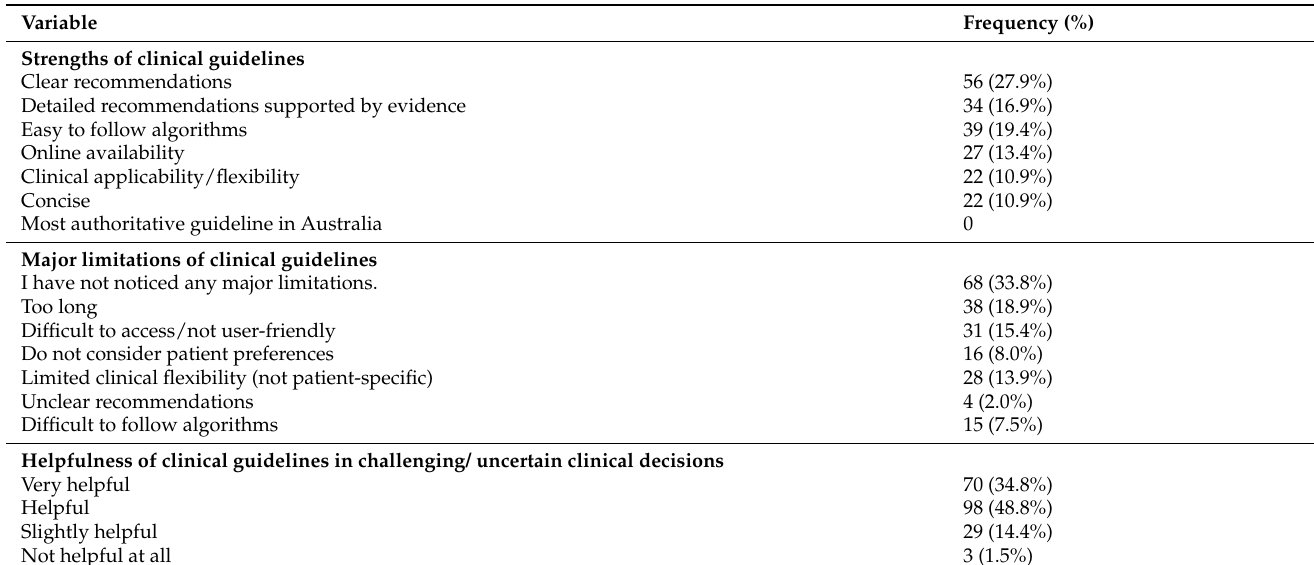
Table A1. Strengths and limitations of thromboprophylaxis recommendations used frequently in AF (n =